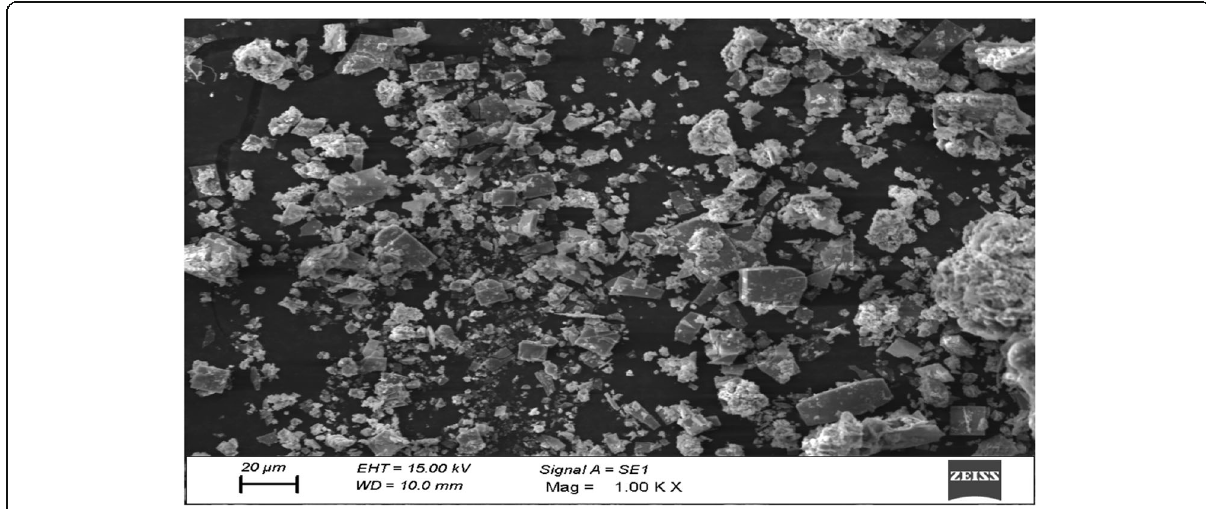
Fig. 3 Scanning electron micrograph of silver nanoparticles